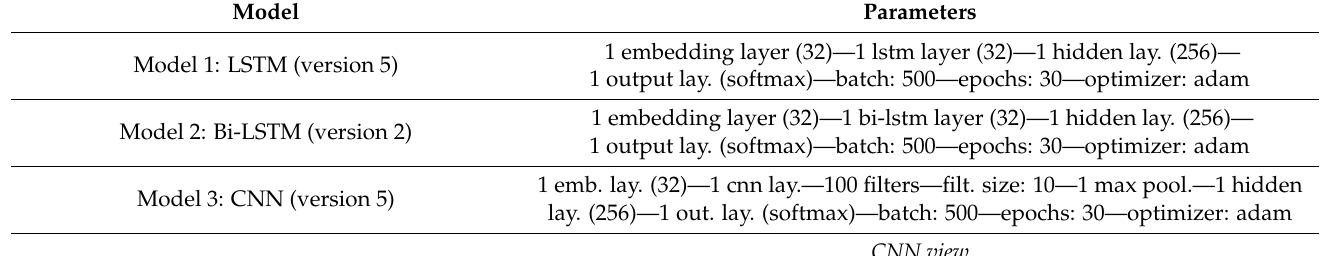
Table 2. Parameter settings for the best version of deep learning-based models. Model Parameters Model 1: LSTM (version